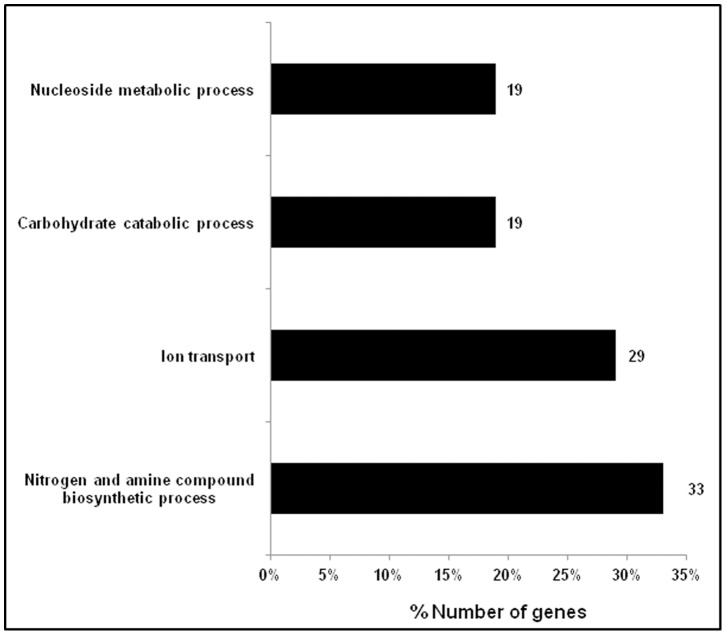
Distribution of down regulated genes (%) based on biological process classification reported by Gene ontology term functional categories using DAVID version 2.0 software.